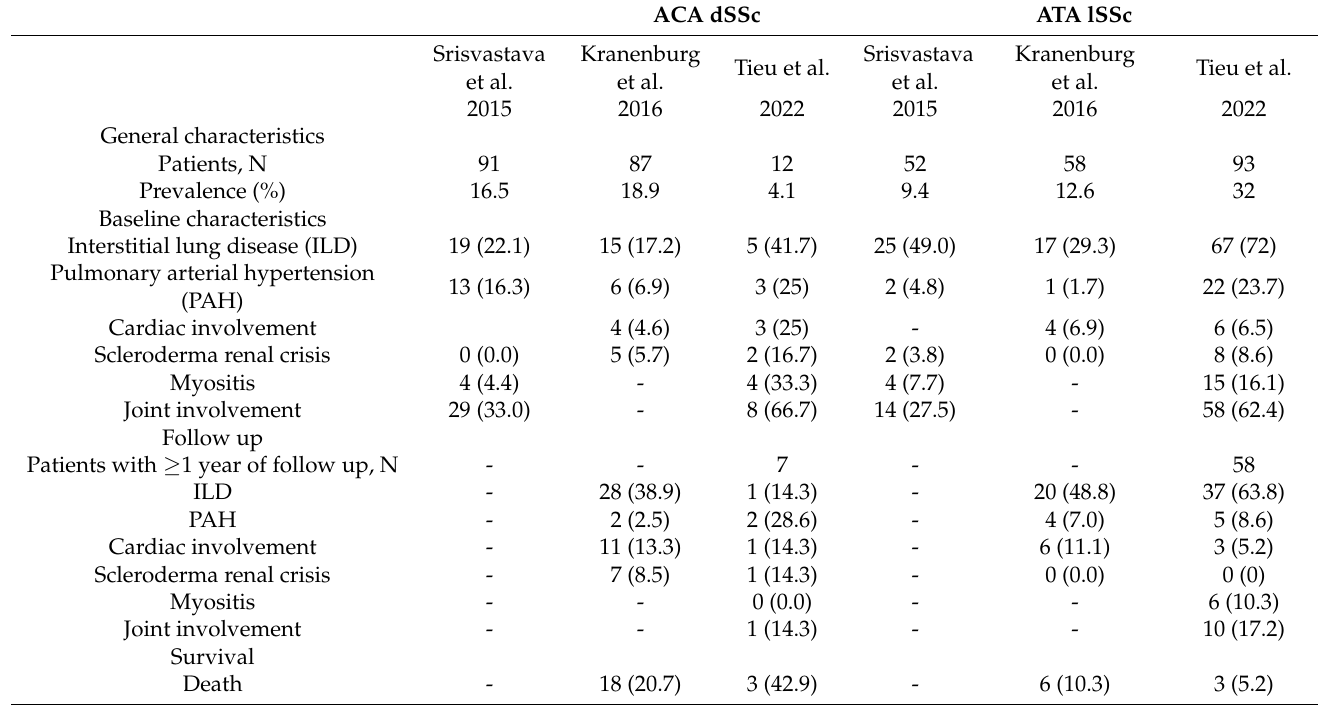
Table 7. Reported series of inverted phenotypes in systemic sclerosis patients. ACA dSSc ATA